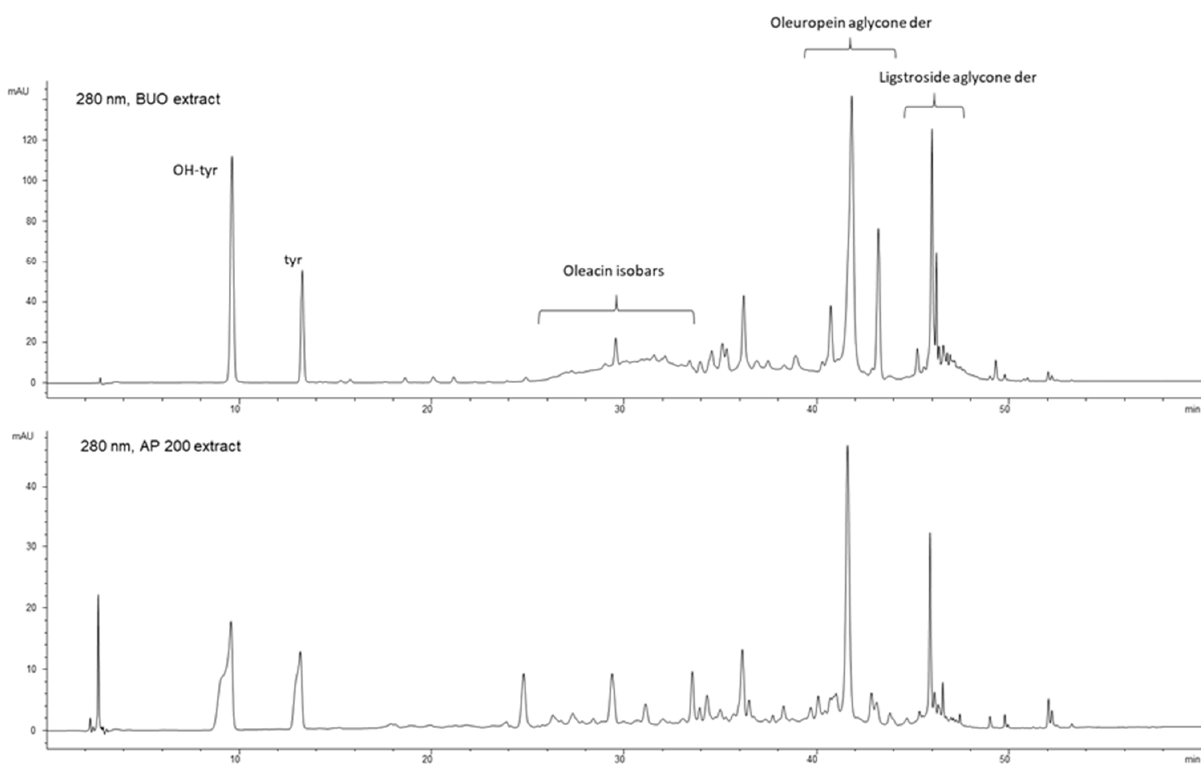
Figure 6. Chromatographic profiles at 280 nm showing OH-Tyr, Tyr, and the main secoiridoidic compounds in BUO and AP200 (AP side of the cells treated at 200 µg/mL ) samples after 2 h incubation in the AP compartment.